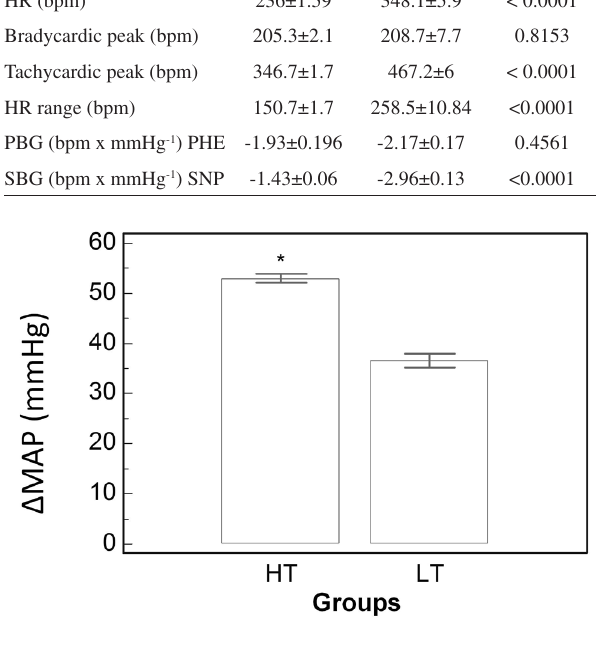
Figure 4 - Decrease in mean arterial pressure (MAP, mmHg) and decrease in heart rate (HR, bpm) in response to sodium nitroprusside (SNP, 50 m g/kg i.v.) in HT (n=20) and LT (n=6) groups. *p<0.001: difference in HT.